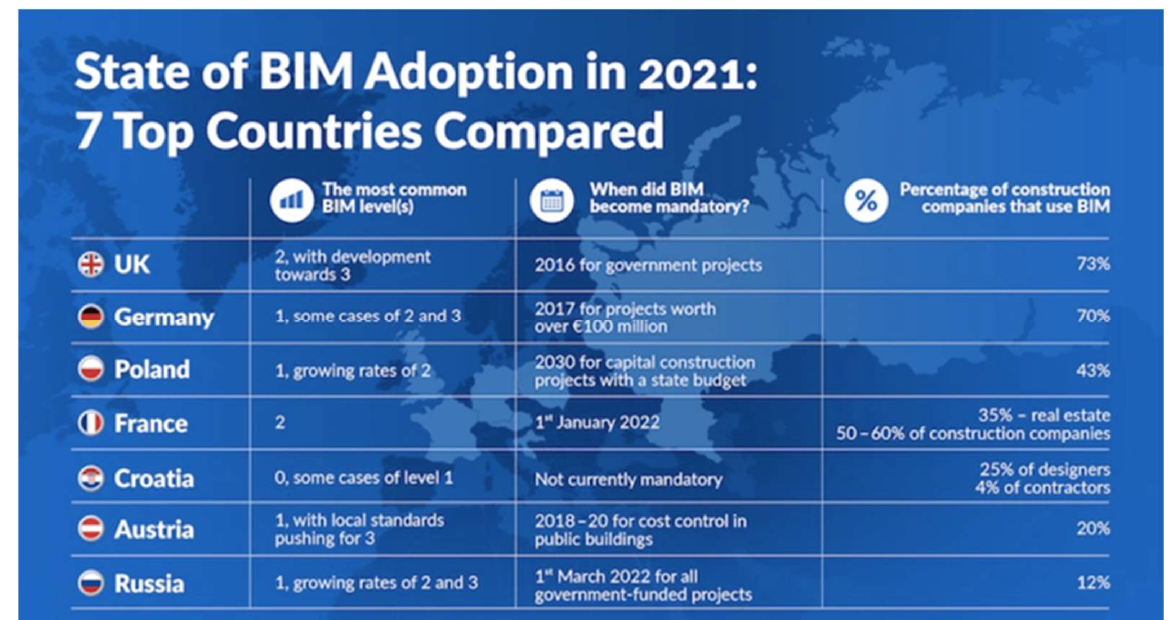
Figure 4. After 2014 to 2022: in dark gray, the European States that have a regulation on BIM; in light gray, the European States that have guidelines.